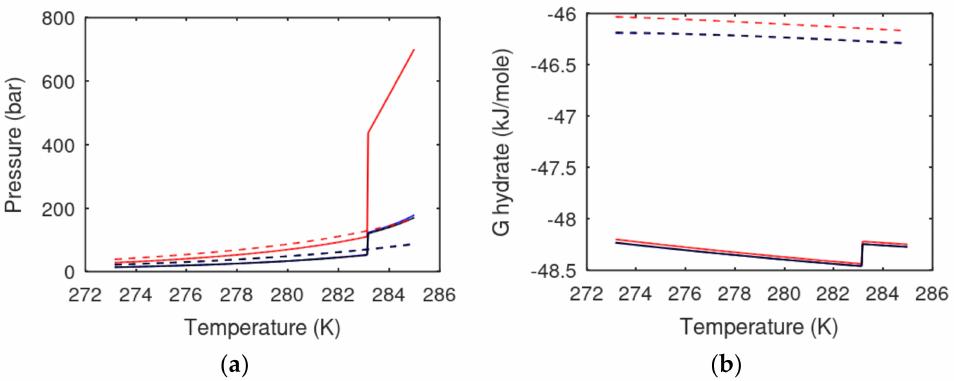
Figure 4. ( a ) CO 2 (solid curves) and CH 4 (dashed curves) hydrate stability limits in temperature pressure projection. Hydrates formed from pure water are in black, hydrates formed from average seawater (mole-fraction NaCl equal to 0.0108) are in blue, and hydrates formed from water containing 0.0394 mole-fraction NaCl are in red. ( b ) Calculated Gibbs free energies for the formed hydrates in ( a